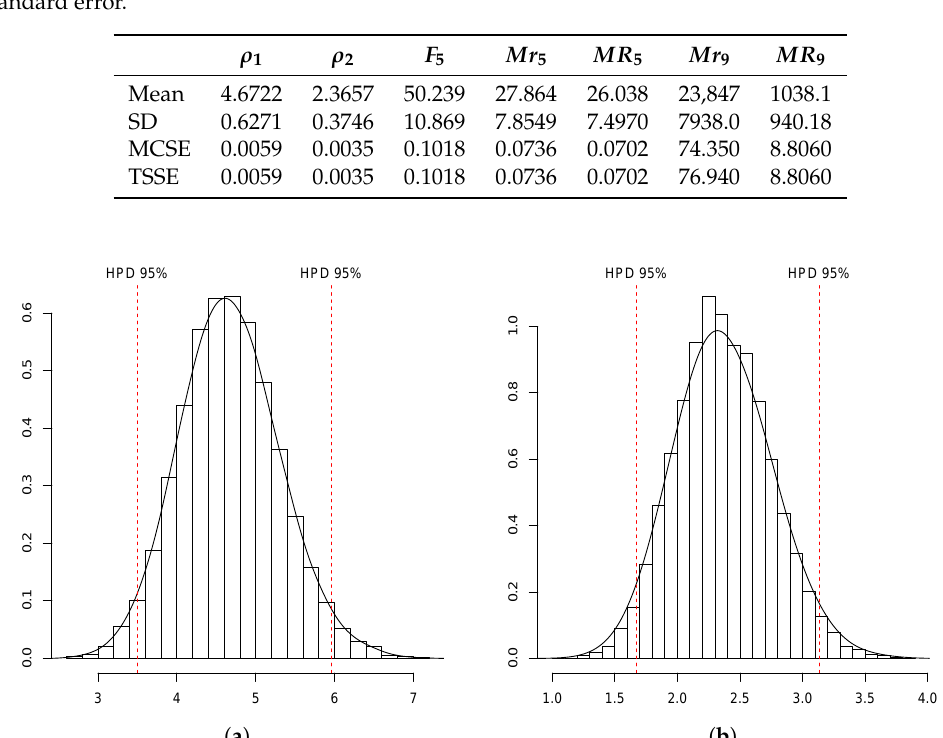
Figure 3. Estimated density for ρ 1 |FM 4 ( a ) and for ρ 2 |FM 4 ( b ), with 95% HPD (highest posterior density)